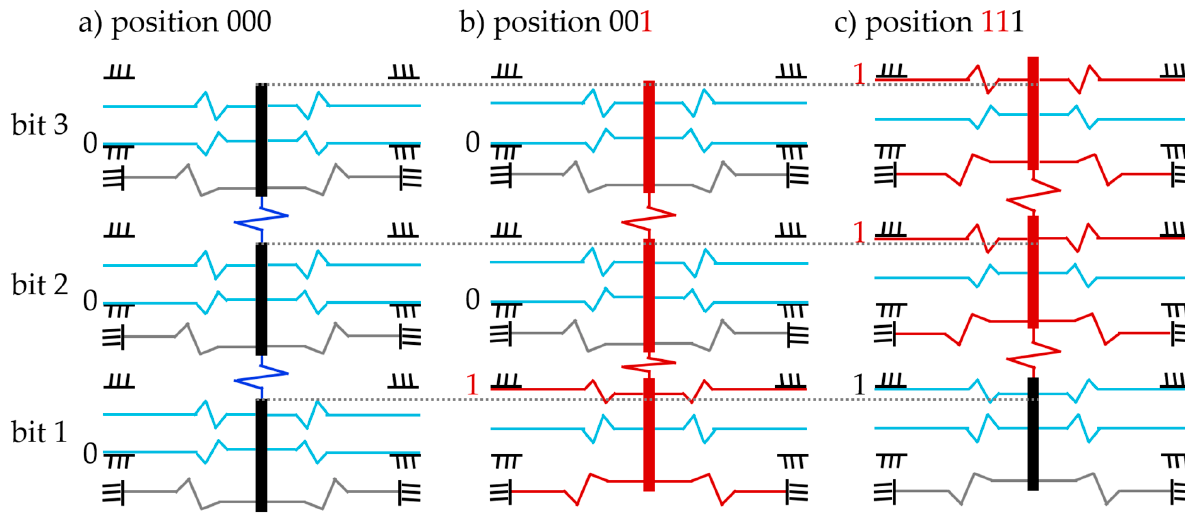
Figure 3. DAC in ( a ) the 000 position by activating the a i ,0 actuators; ( b ) the 001 position by activating the a 1,1 , a 2,0 and a 3,0 actuators and ( c ) the 111 position by activating the a i ,1 actuators. (drawings not to scale).